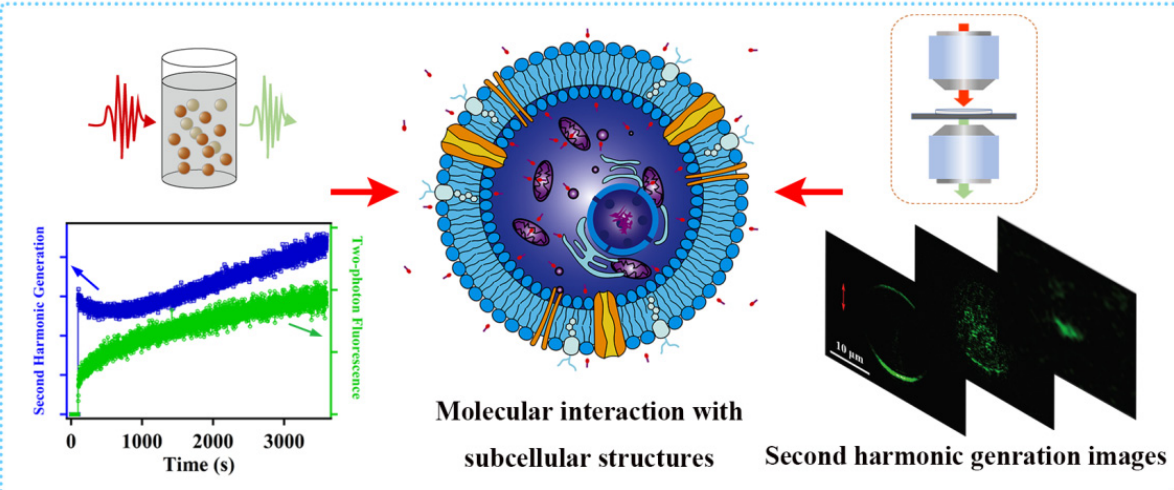
Figure 17. Left: Top is a schematic illustration showing the scattering of SHG and TPF signals from cells upon laser excitation. At the bottom is the time-dependent SHG and TPF curves. In the middle is the schematic illustration of the distributing of D289 molecules (small rod like structures with a red “head”) outside and in a K562 cell. Right: Top is a schematic illustration of the imaging setup. At the bottom are successive SHG images after D289 was introduced to the K562 cell. Reproduced with permission [62]. Copyright 2021 American Chemical Society.